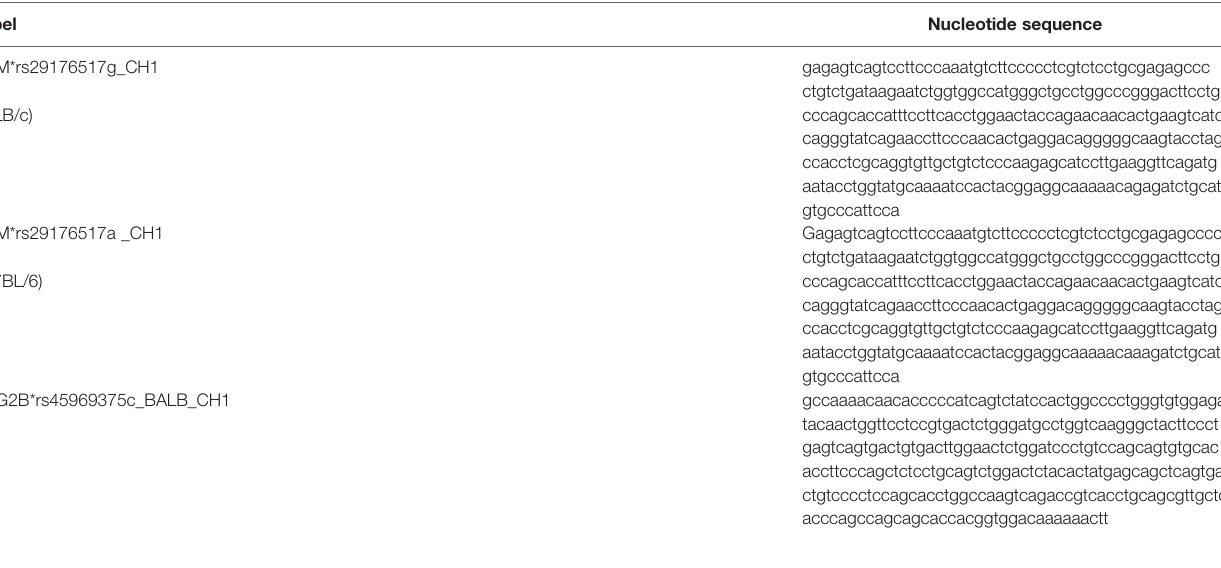
TABLE I | New BALB/c IGHV sequences identi fi ed in this study.